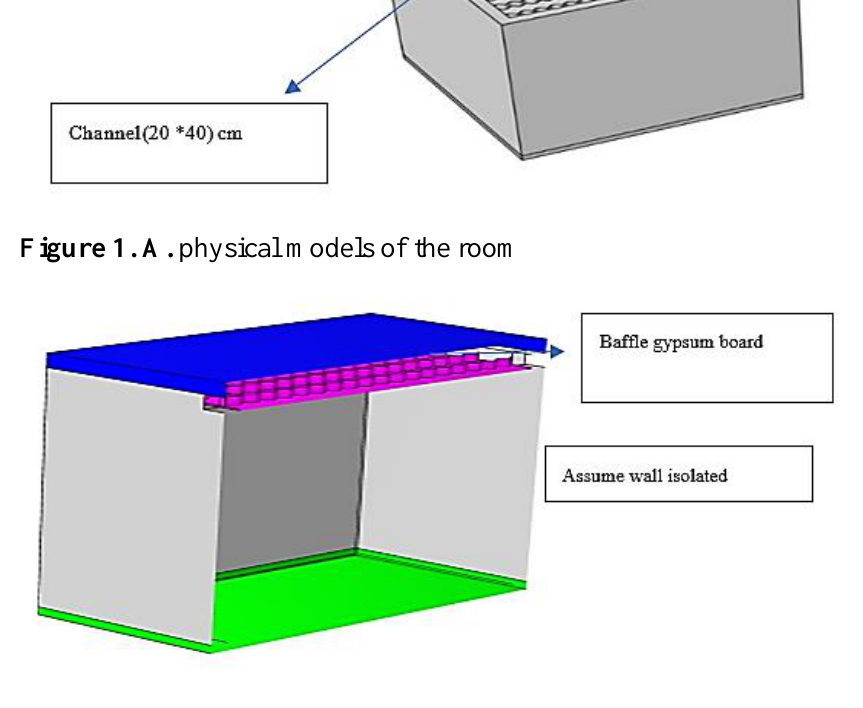
Figure 1. B. section of the room with